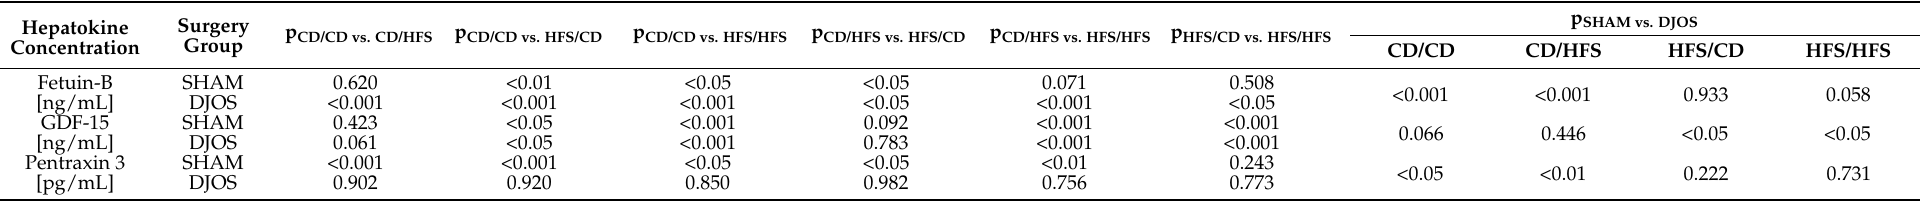
Table 6. Contrast analysis Fetuin-B, growth differentiation factor-15 (GDF-15), and pentraxin 3 concentrations in plasma of Sprague–Dawley rats subjected to control (SHAM) and duodenojejunal omega switch (DJOS) surgery and different dietary regimes eight weeks after the surgery. Statistical significance was set at p < 0.05. Hepatokine